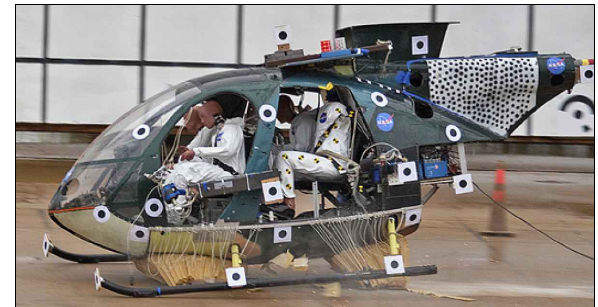
Figure 9 – Crash-test of a helicopter MD-500 with a crew of four anthropometric dummies - Hybrid III dummies